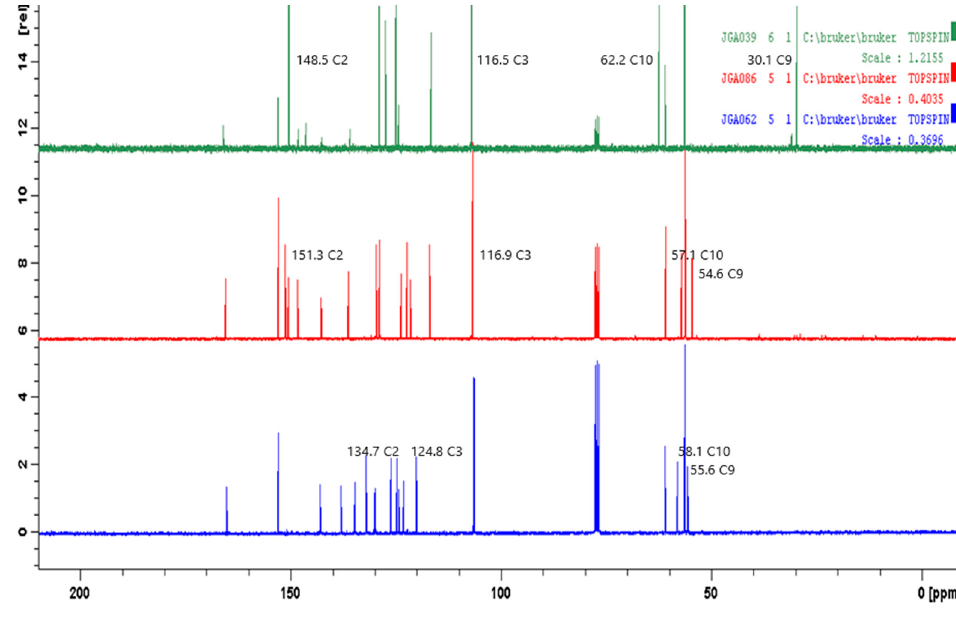
Figure 3. 13 C NMR spectra of compounds 14 , 46 , 67 .